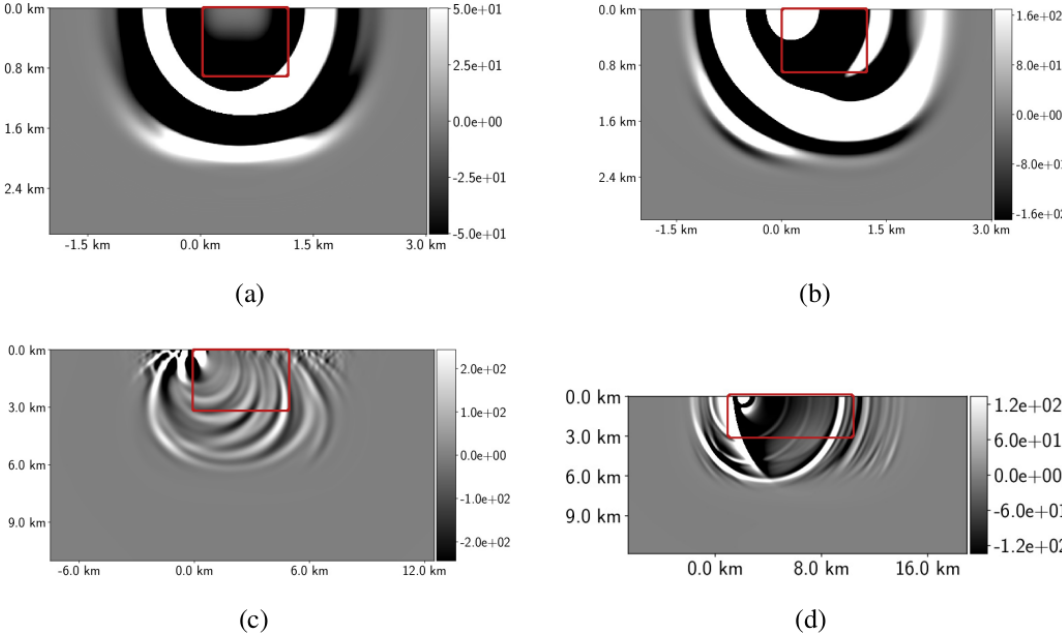
Figure 7. Reference solutions of the adjoint u † wave equation related to the velocity models. (a) Circle velocity model at t = 1s. (b) Hori- zontal layers at t = 1s. (c) Part of the Marmousi velocity model at t = 6 . 4s. (d) 2D SEG EAGE salt model at t = 5s. The regions inside the red square are the physical domains, with the red lines indicating the boundaries ( ∂(cid:127) 0 ), and the regions outside are the extended domain.